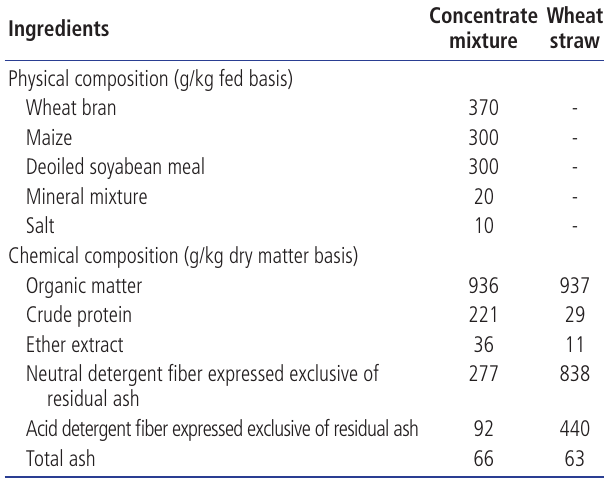
Table 1. Chemical composition (g/kg) of concentrate mixture and wheat straw